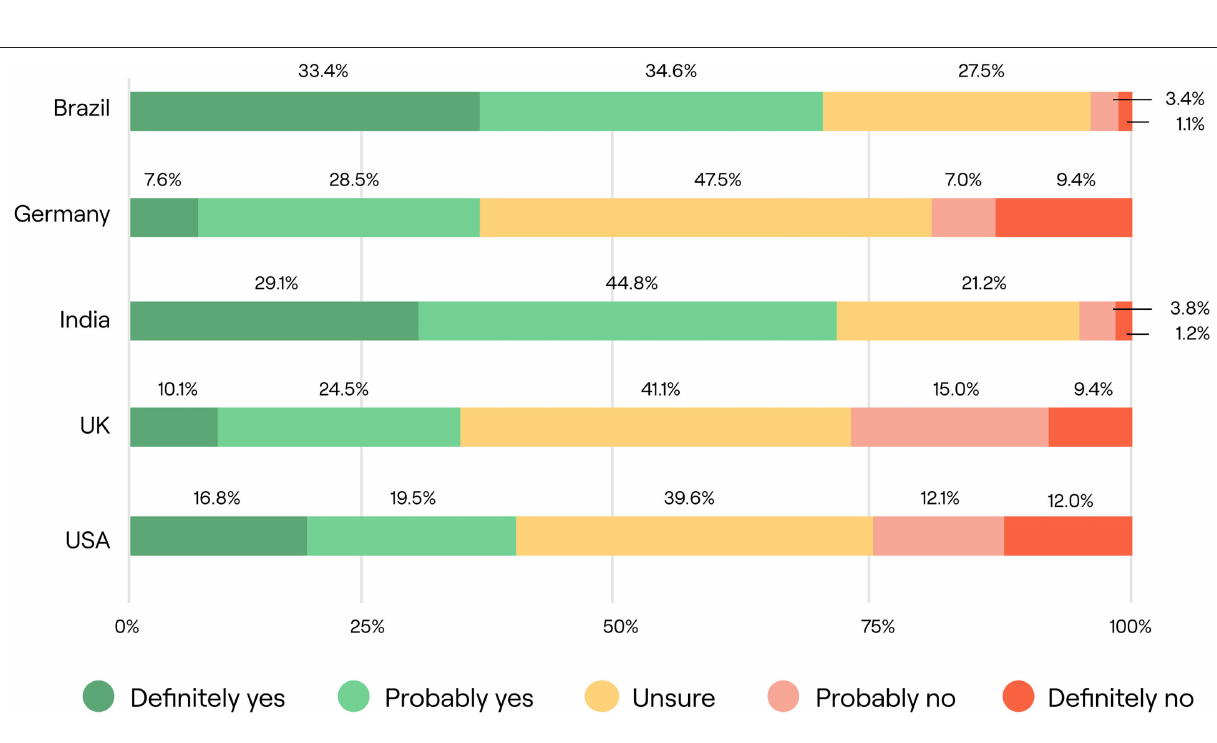
FIGURE 4 | Willingness to regularly buy animal-free dairy cheese across